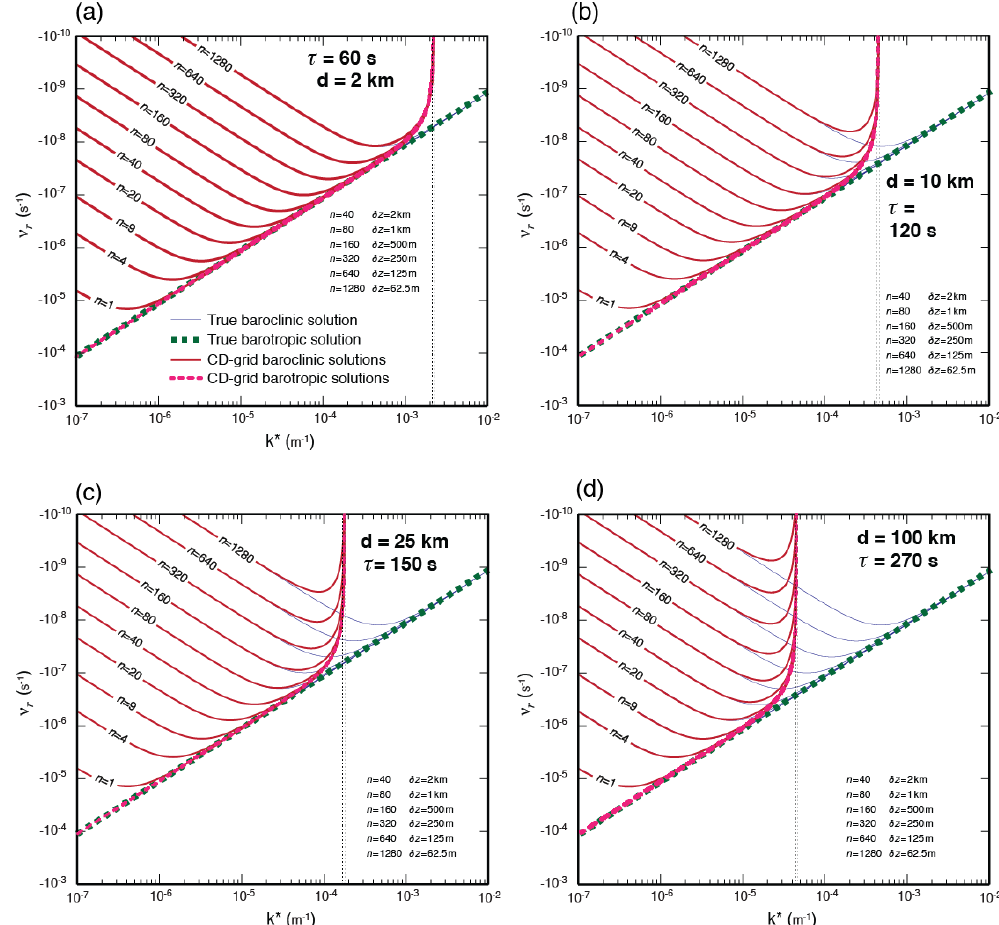
Figure 3. Same as Fig. 1 but on the CD